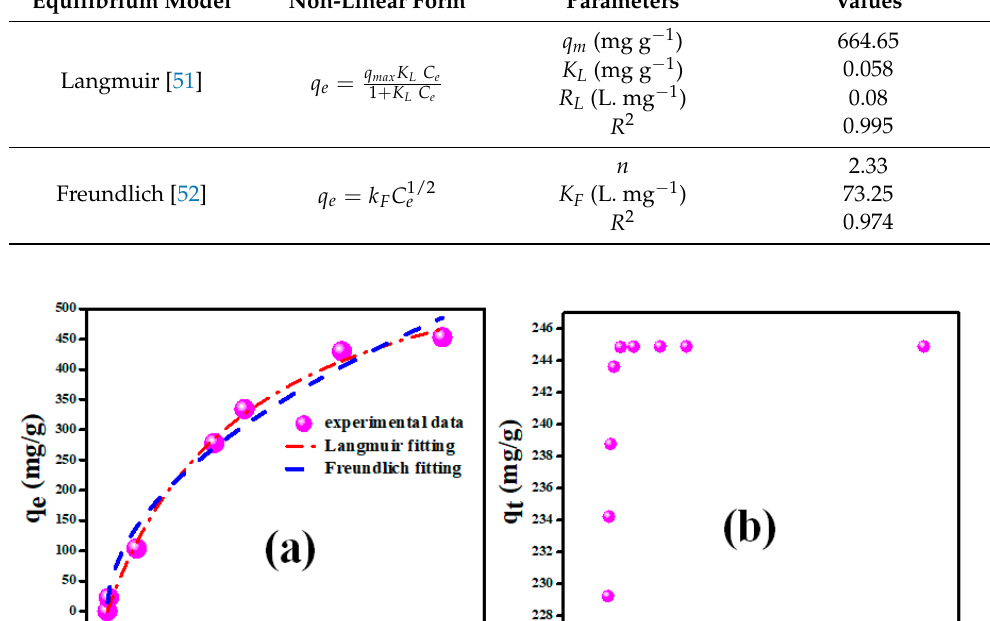
Table 1. Equilibrium isotherm constants models for CV dye adsorption by the V 2 O 5 -g-C 3 N 4 nanosorbent. Equilibrium Model